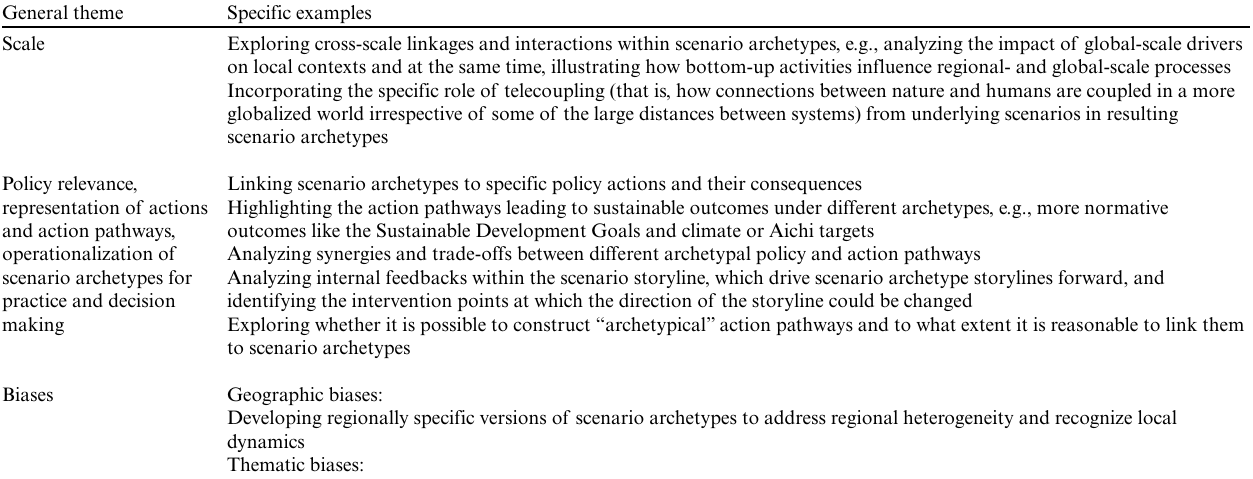
Table 4 . Summary of research frontiers of the scenario archetype approach, identified by a survey among Intergovernmental Science- Policy Platform for Biodiversity and Ecosystem Services (IPBES)